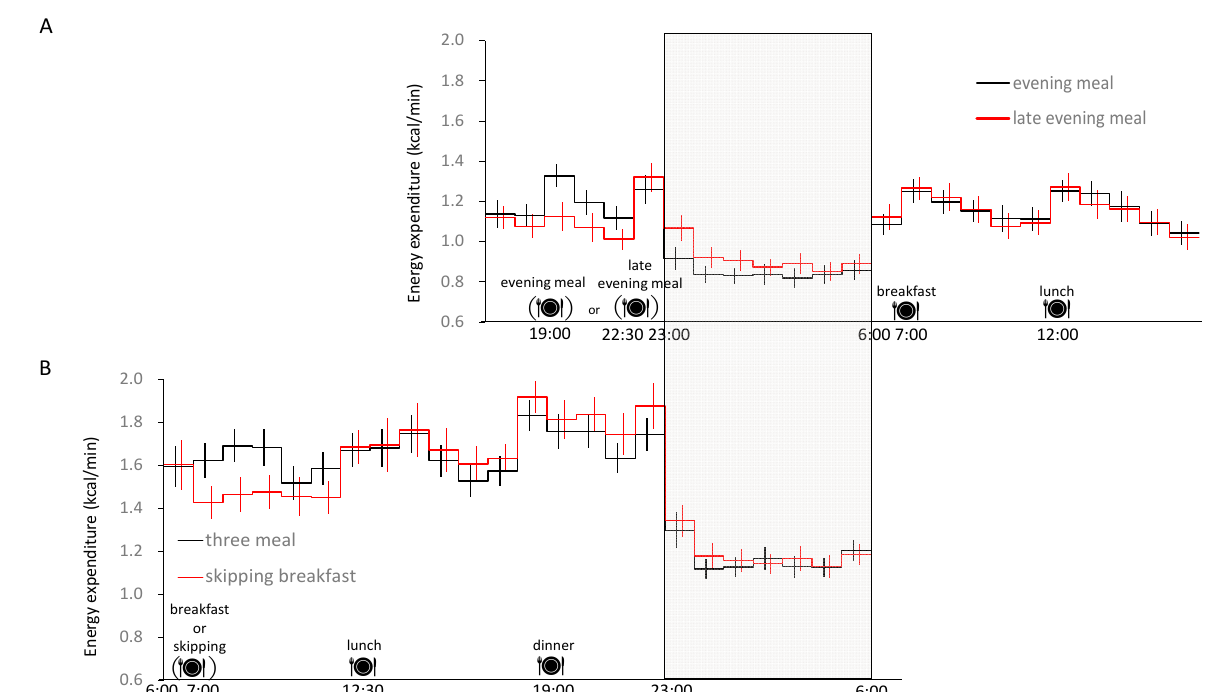
Figure 2. Twenty-four-hour blood glucose profile. Time course of energy expenditure for ( A ) ordinary (19:00) and late-evening meal (22:30) [7], and ( B ) skipping breakfast [9], as assessed by whole-room indirect calorimetry. Bedtime (23:00) and wake-up time (6:00) were identical in the two studies. The 24 h energy intake within each study was matched (i.e., the caloric intake of lunch and dinner was increased to compensate for the skipped breakfast). The gray area indicates sleep time, and bedtime (23:00) is shown in vertical rows. Partially modified from [7,9].